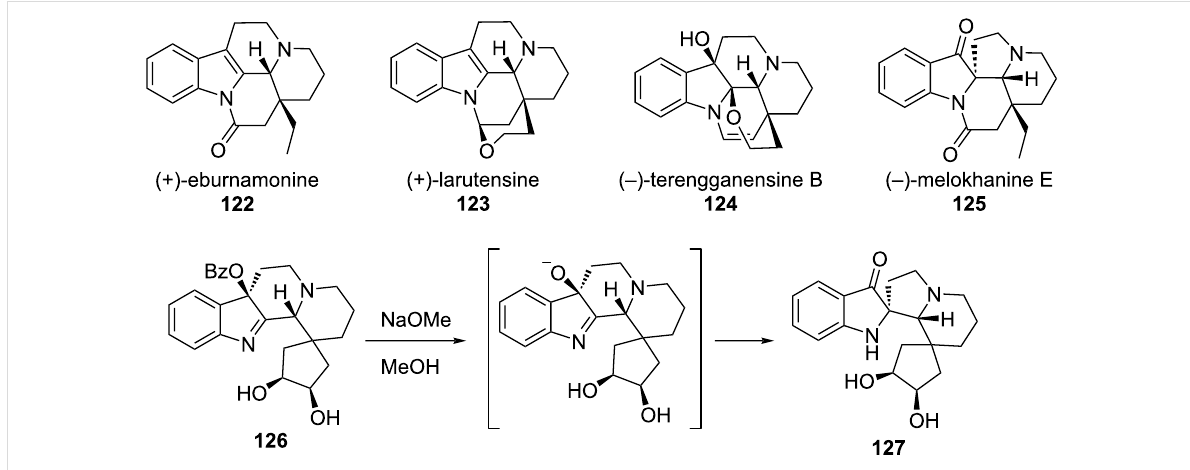
Figure 22: Four eburnane-type alkaloid natural products 122 – 125 were synthesized from common intermediate 127 , which was produced from known precursor 126 by an α -iminol rearrangement.